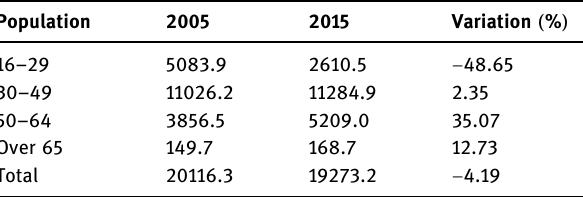
Table 2: Changes in employment per age group during the 2005 – 2015 period ( stated in thousands of jobs )